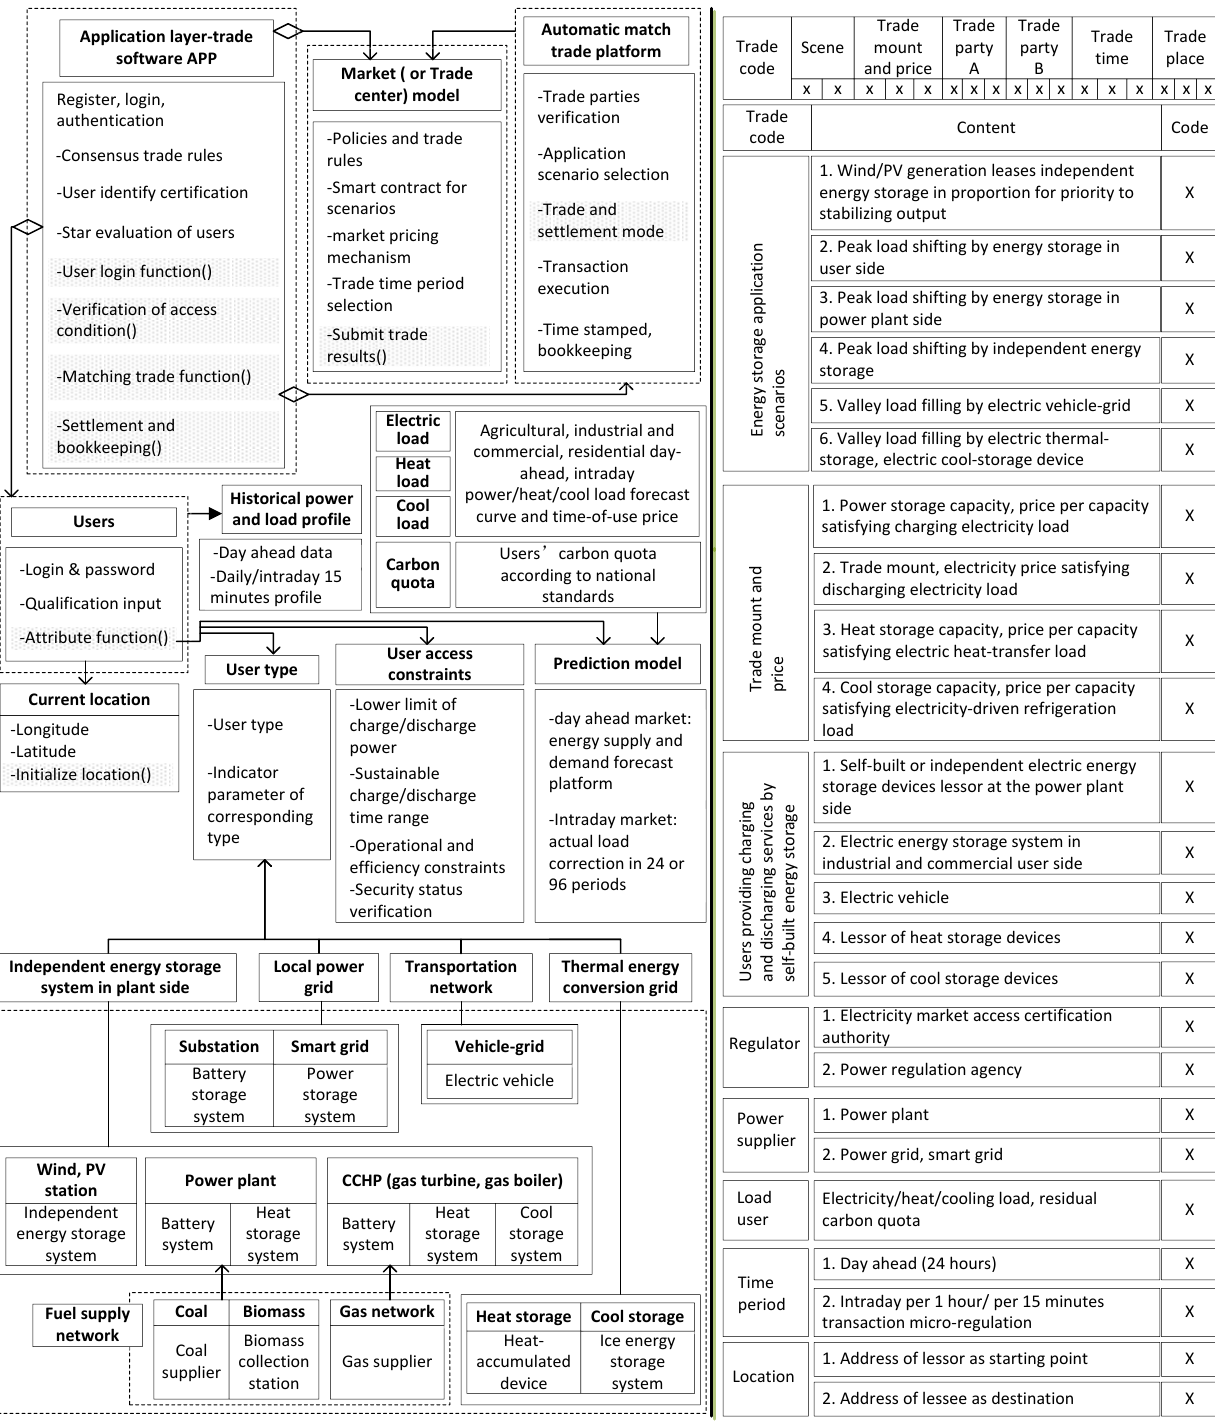
Figure 2. Unified model architecture for trade participators, flowchart and trade code.